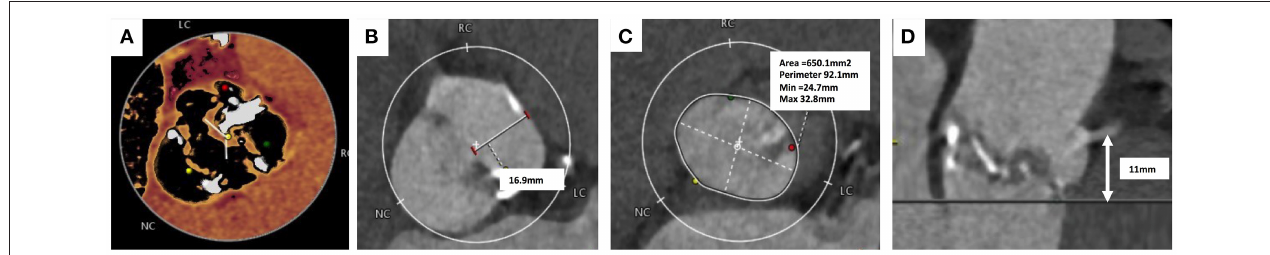
FIGURE 3 | Computer Tomography Imaging of bicuspid aortic valve. (A) Sievers Type 1 Raphe-type bicuspid aortic valve (BAV) with mixed cusp fusion (left-right). (B) Large bulky cusps measuring 16.9mm maximum diameter. (C) Asymmetric large annulus. (D) Low lying coronary ostia at 11mm combined with large bulky leaflets indicate a risk of coronary occlusion during